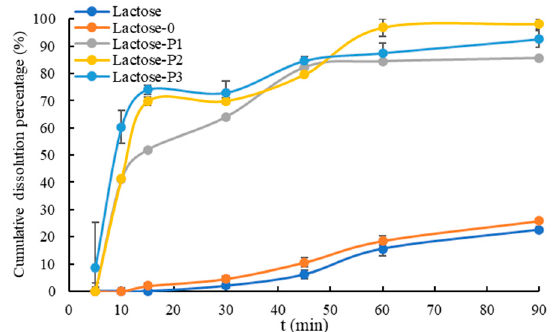
Figure 5. In vitro dissolution behavior profiles of Cur-loaded powder. Lactose, the raw material; Lactose-0, processed without PVP K30; Lactose-P1, processed with 1% PVP K30; Lactose-P2, pro- cessed with 2% PVP K30; Lactose-P3, processed with 3% PVP